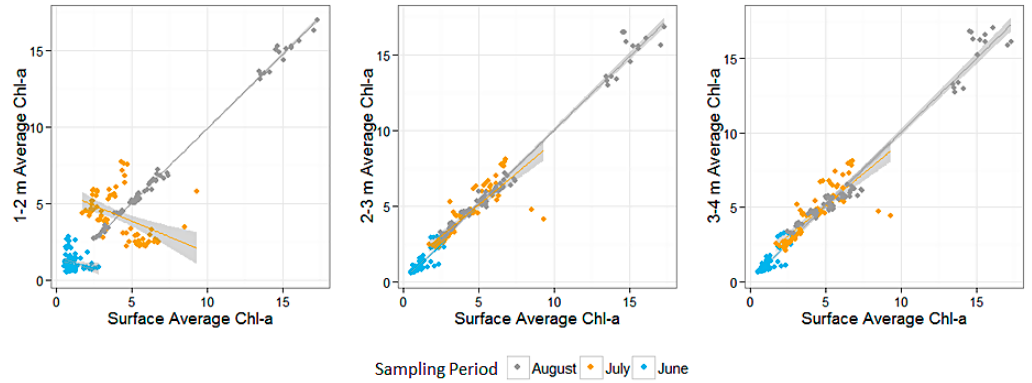
Figure 8. Relationships between Surface and Depths throughout the Water Column for GB Sites.